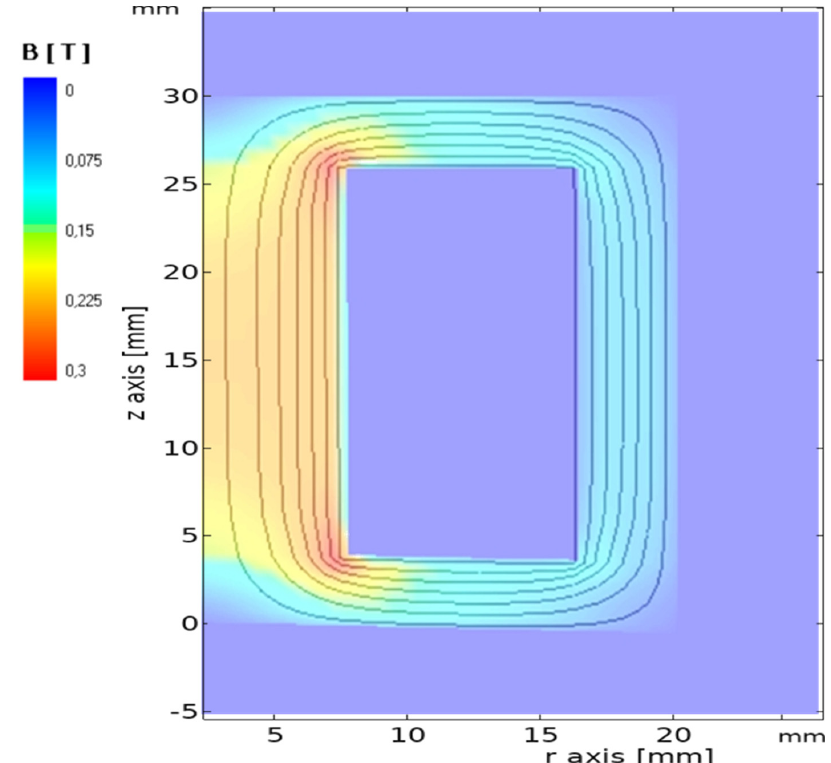
Figure 10. Magnetic flux density B distribution in the considered inductor for t = 0.25 ms for a frequency of 1 kHz.